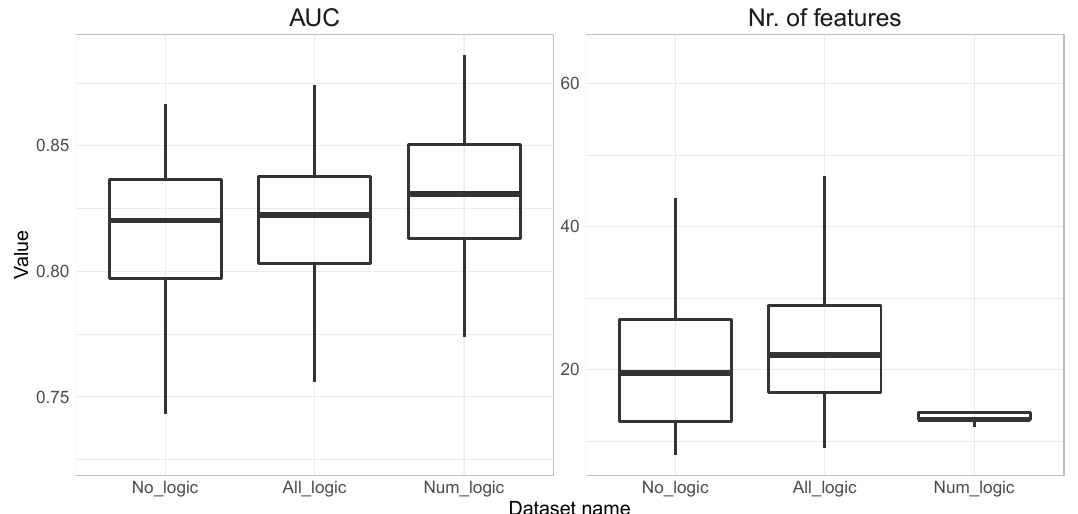
Figure 1. Selected features with the Least Absolute Shrinkage and Selection Operator (LASSO) on the dataset with numeric and logic features.